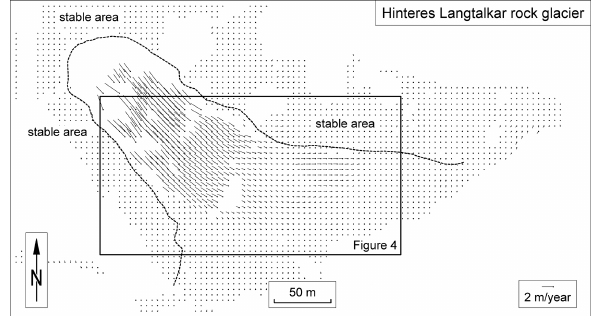
Figure 3. Mean annual horizontal displacement vectors of Hinteres Langtalkar rock glacier derived from image data of Google Maps (epoch 2002) and Microsoft Bing Maps (epoch 2006). GSD: 80 cm, grid spacing: 12 × 12 pixel, template size for image matching: 25 × 25 pixel, 2573 valid points, precision of measurements: ±10.0 cm/year (1 sigma), maximum displacement: 3.31 m/year.